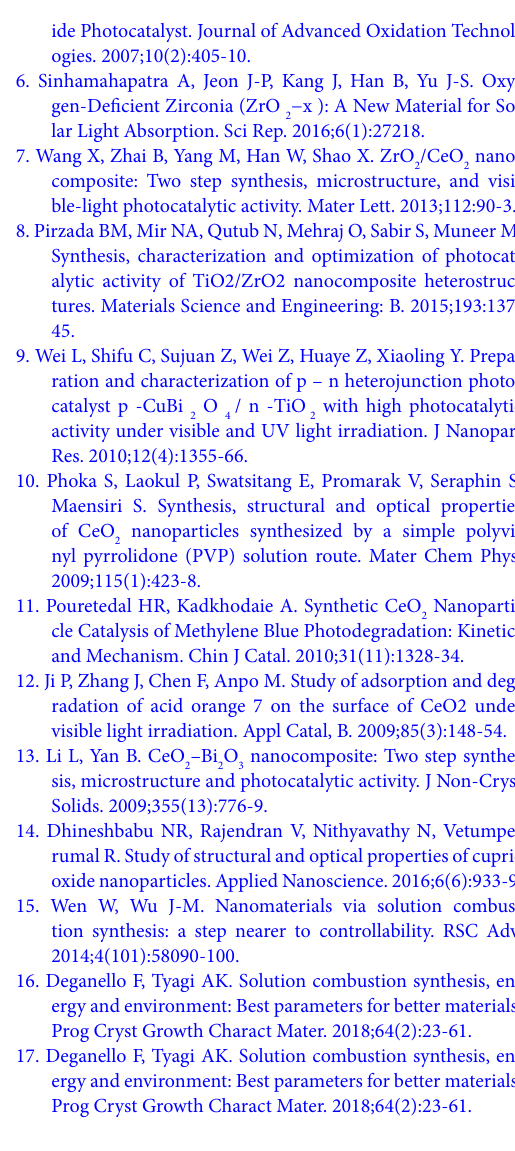
ZrO photocatalyst. 2 2